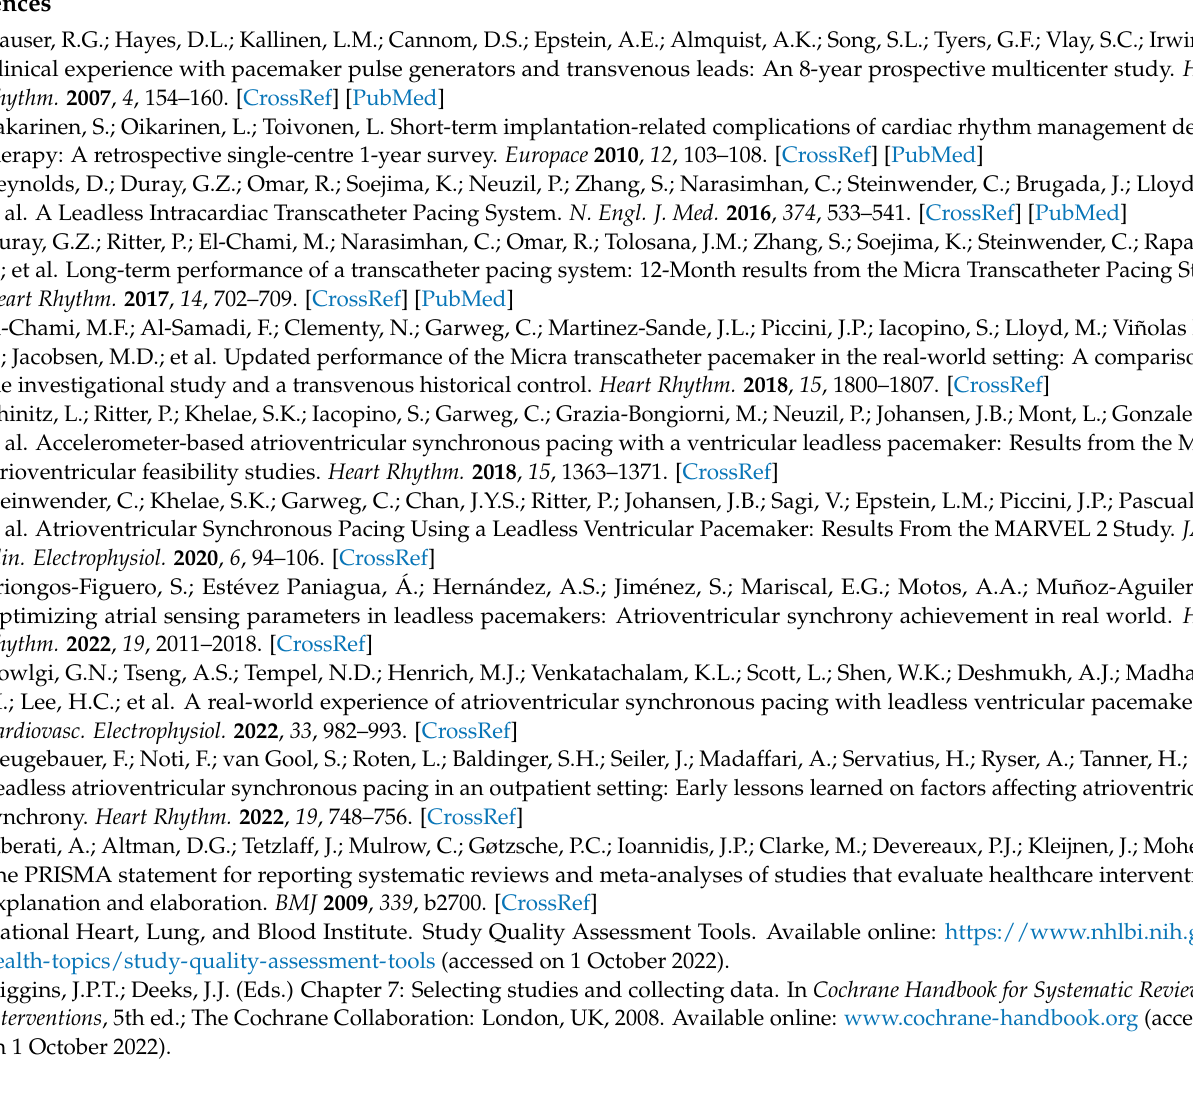
Table S1. The quality assessment of included studies using the National Institutes of Health (NIH) quality assessment tool for before–after (pre-post) study with no control group; Figure S1: The sensitivity analysis of studies included for atrioventricular